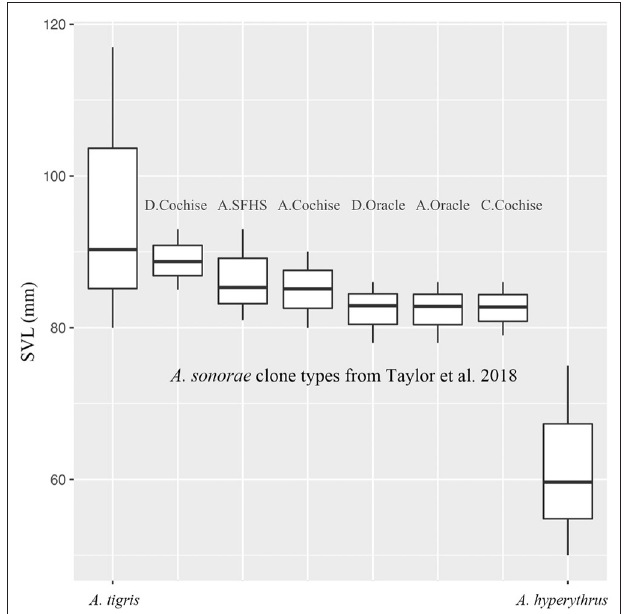
FIGURE 2 | Body size (snout to vent length [SVL] in mm) for native species of Aspidoscelis from Southern California and pattern classes for Aspidoscelis sonorae (Taylor et al., 2018). Note that Taylor et al. (2018) only examined the largest adults in their populations (those over 77mm SVL); thus, comparisons should only be made across maximum sizes of each group. Aspidoscelis sonorae from Taylor et al. (2018) are listed as the pattern class (A, C, or D) and then the location (Cochise, SFHS, or